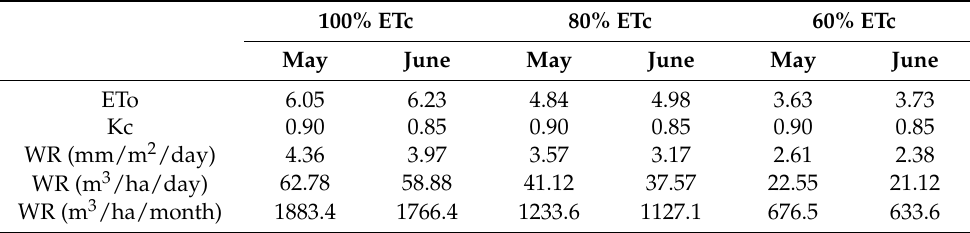
Table 3. Plum water requirement (WR) based on three different evapotranspiration levels (ETc = 100%, 80%, or 60%), calculated from the reference evapotranspiration (ETo) and coefficient factor (Kc) during the May–June period (data are the average of the 2019 and 2020